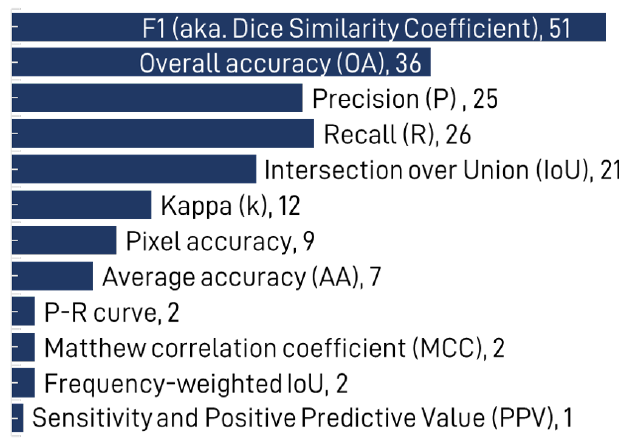
Figure 10. Overview of performance metrics used to evaluate the results of deep learning